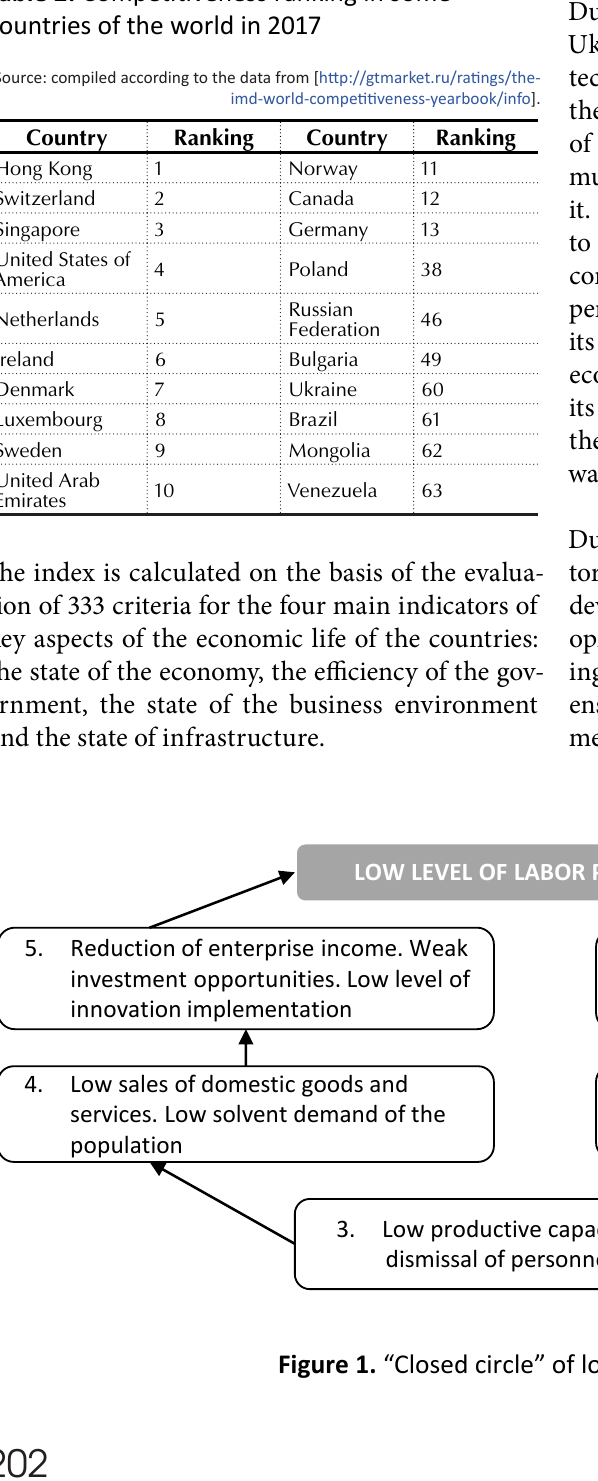
Table 2. Competitiveness ranking in some countries of the world in 2017